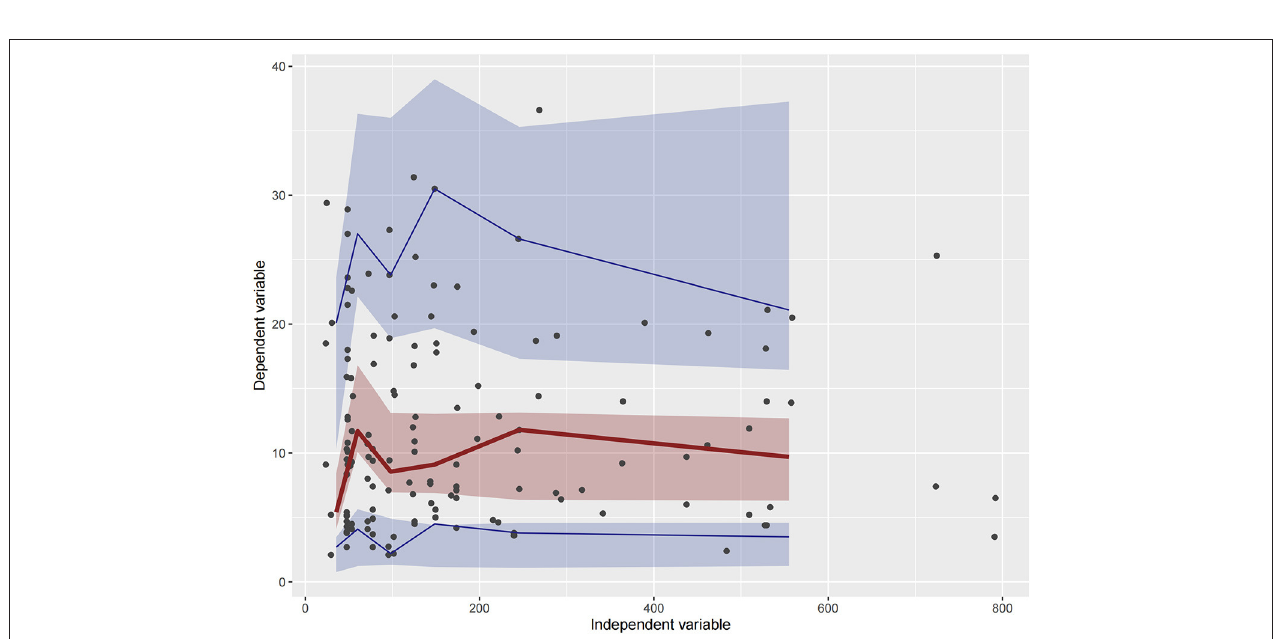
FIGURE 5 | Visual predictive check (VPC) of Model 2. Circles represent observations. The red solid lines represent the median of simulated concentrations, and the blue solid lines represent the 90% PI (5 and 95%) of the predictive vancomycin concentrations. The shaded areas represent the 95% CI for each line.